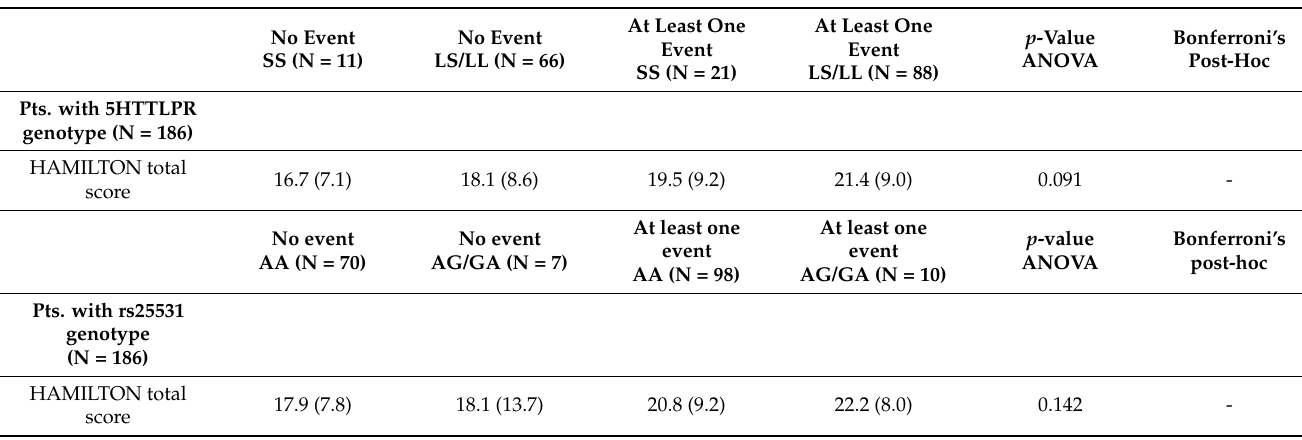
Table 5. Effect of major stressful events in the 6 months preceding illness onset and 5HTTLPR and COMT genotypes on the depression (HAMILTON) mean